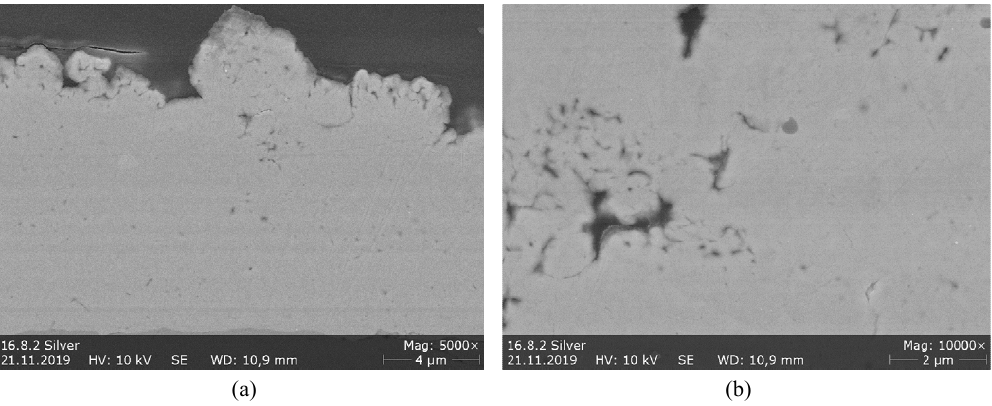
Figure 17. SEM images of Ag-coating on copper substrate with parameter set 60/100, λ =0,55, 90mm, (refer to Figure 16 last row). ( a ) near surface ( b ) details of pore structure.